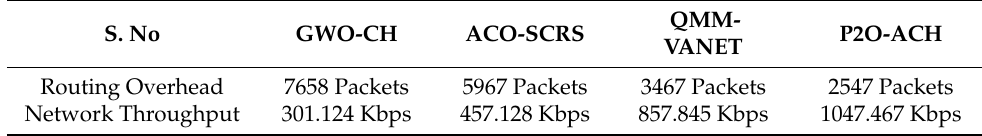
Figure 9. Network Throughput Calculation.